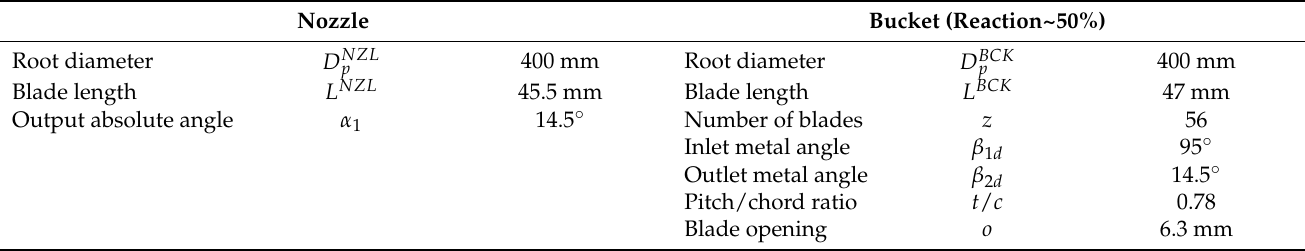
Table 1. Geometric parameters of tested stages.